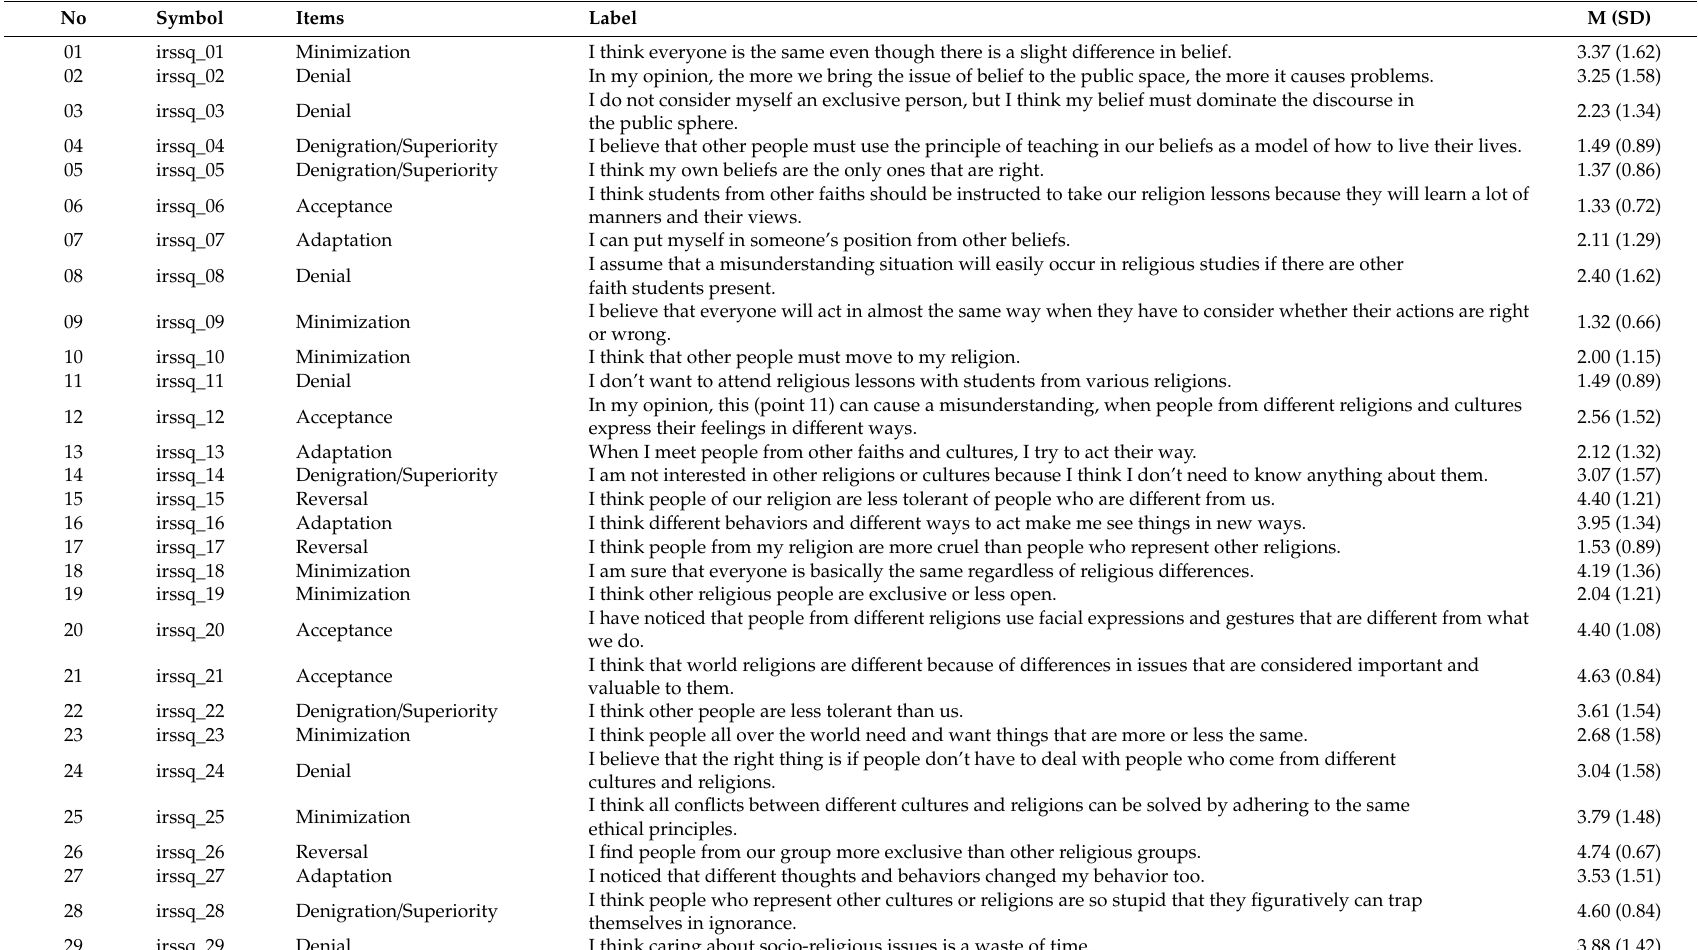
Table 3. Intercultural and Religious Sensitivity Scale Questionnaire (IRSSQ)